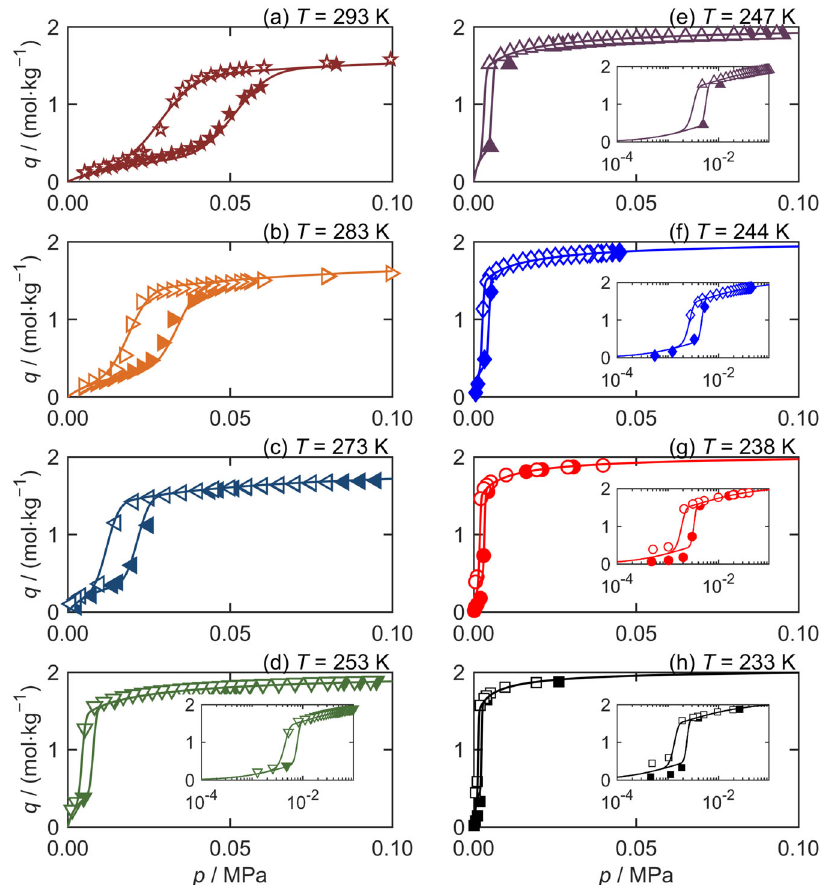
Fig. 3 Asymptotic isotherm hysteresis with decreasing temperature for CO 2 on ZIF-7. Equilibrium CO 2 capacities, q , measured in adsorption ( fi lled symbols) and desorption (empty symbols) for ZIF-7 at pressures, p , to 0.1 MPa, for eight temperatures T from a 293 K to h 233 K. Curves represent fi ts of the LJMY-Langmuir model (Equation 1 and described in Note 1 of the SI). Insets show the hysteresis of low temperature isotherms on a logarithmic pressure scale.